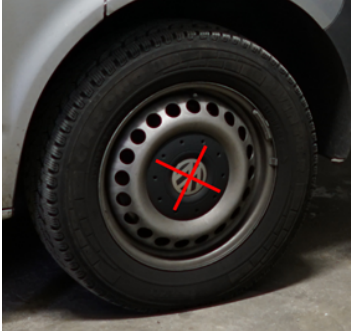
Figure 4: Rim centres (red cross) are used as ground control points for the transformation into the vehicle coordinate